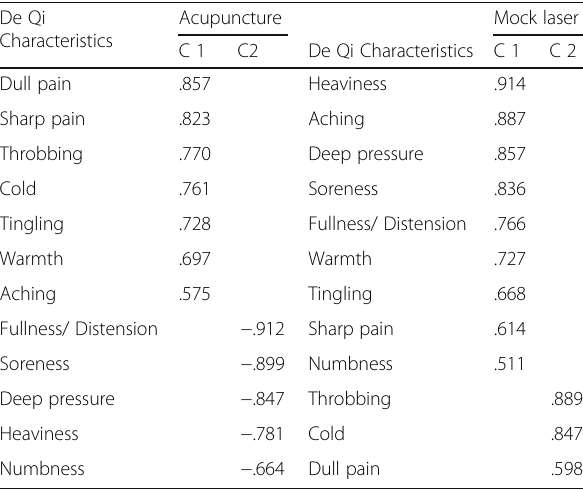
Table 5 Factor loading of De Qi perception of sensory responses in the two study groups De Qi